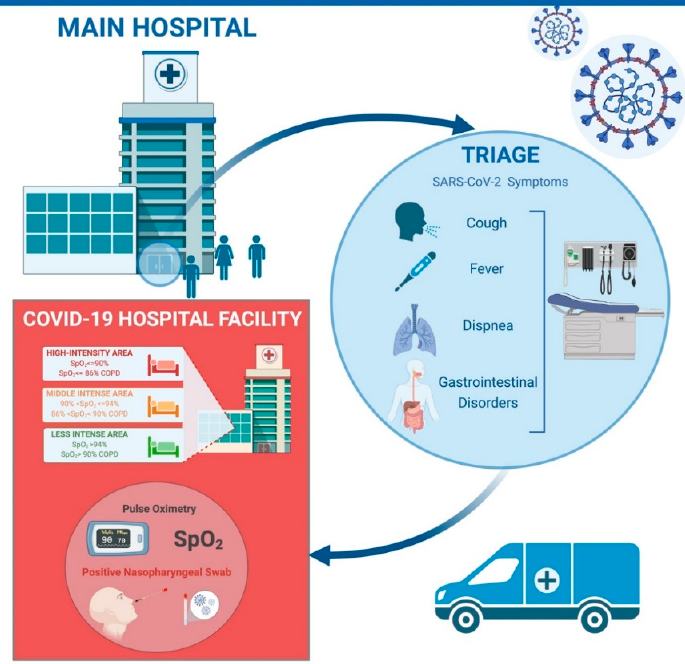
Figure 1. Lean operational algorithm used during the COVID-19 outbreak.